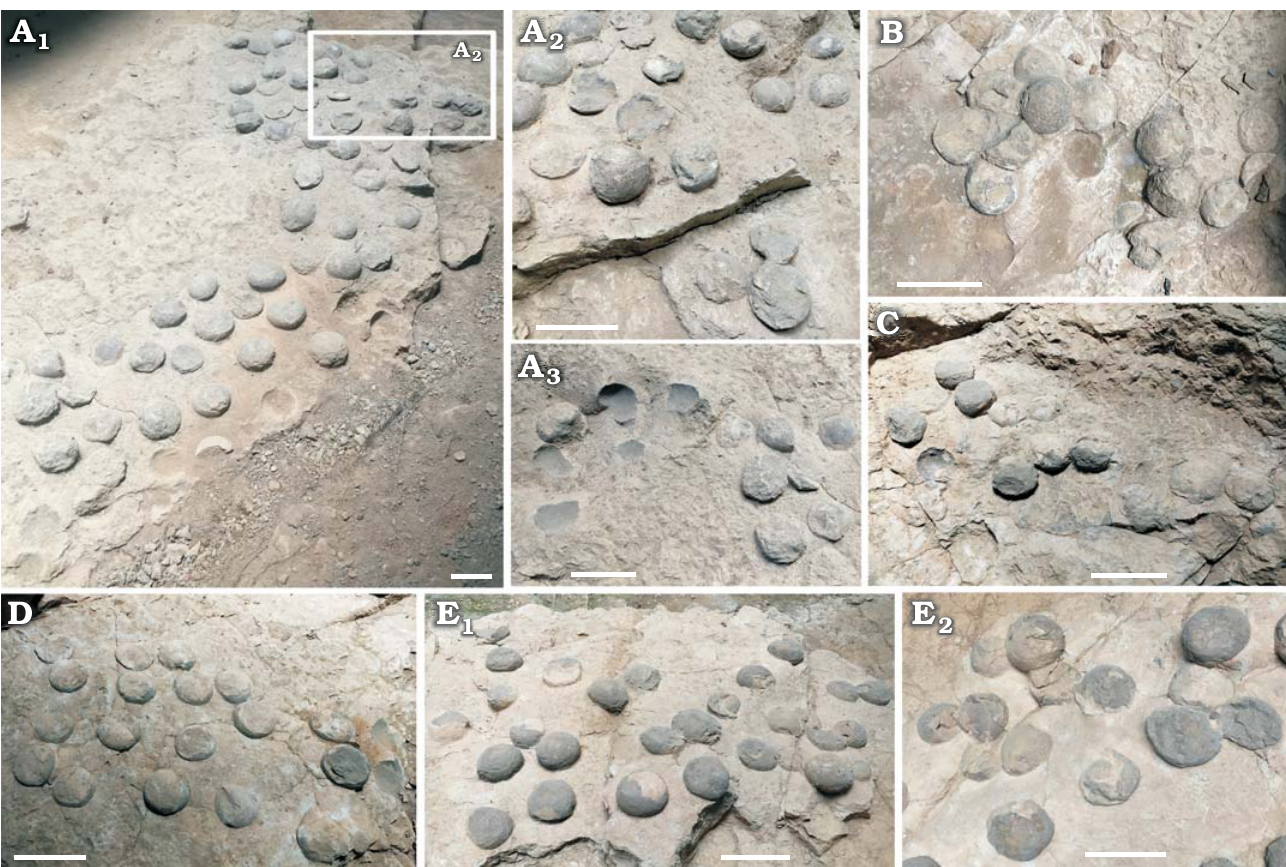
Fig. 2. Clutches of dendroolithid eggs of Placoolithus tumiaolingensis (Zhou, Ren, Xu, and Guan, 1998) comb. nov. from the Upper Cretaceous of the Tumiaoling outcrop, Yunxian, Hubei Province, China. A . TML 4; A 1 , general view; A 2 , the lower eggs; A 3 , higher egg and egg impressions. B . TML